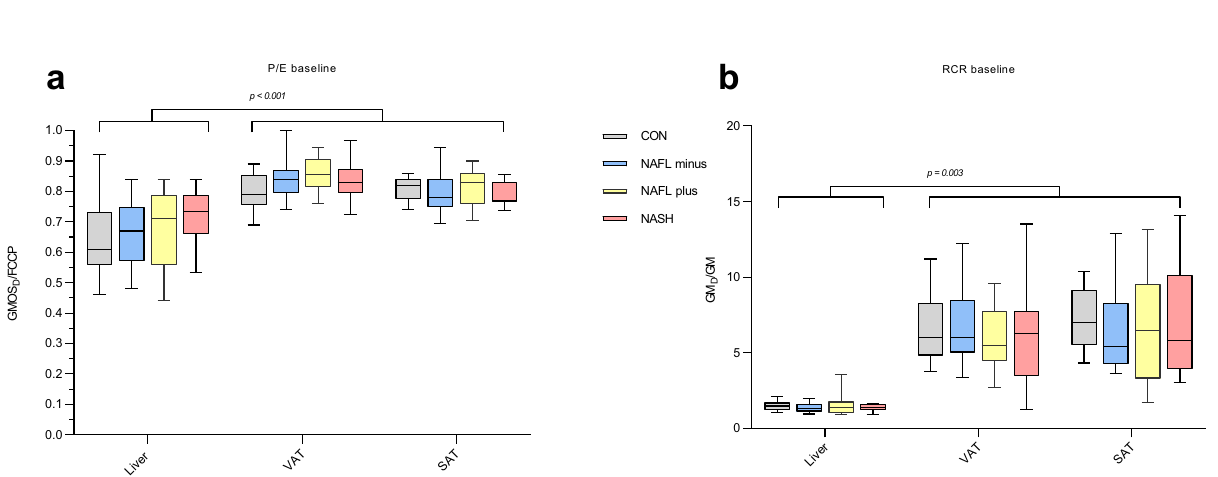
Fig. 3 Mitochondrial respiratory rates in visceral- and subcutaneous adipose tissue (VAT and SAT, respectively) at baseline. a Mass-speci fi c substrate-inhibitor protocol 1 (SUIT P1) visceral adipose tissue (VAT) fl uxes. c P1 VAT fl uxes adjusted to mtDNA/nDNA. b Mass-speci fi c substrate- inhibitor P1 subcutaneous adipose tissue (SAT) fl uxes. d P1 SAT fl uxes adjusted to mtDNA/nDNA. e Adipocyte count per counting frame (0.4 mm 2 ) in VAT and SAT, respectively. f Number of CD68 + macrophage per 100 adipocytes in VAT and SAT. Data are median (horizontal line), interquartile range (boxes) and 10 – 90% percentile (error bars). P -values (2-sided) are Kruskal – Wallis pairwise comparison with correction for multiple comparison. Grey boxes; CON, blue boxes; NAFL − , yellow boxes; NAFL + , red boxes; NASH. VAT: NAFL − n = 30, NAFL + n = 12, NASH n = 14, CON n = 9. SAT: NAFL − n = 29, NAFL + n = 13, NASH n = 14, CON n = 9. Source data are provided as a Source Data fi le. Speci fi c n ’ s for each substrate and group are provided in the Source Data fi le.